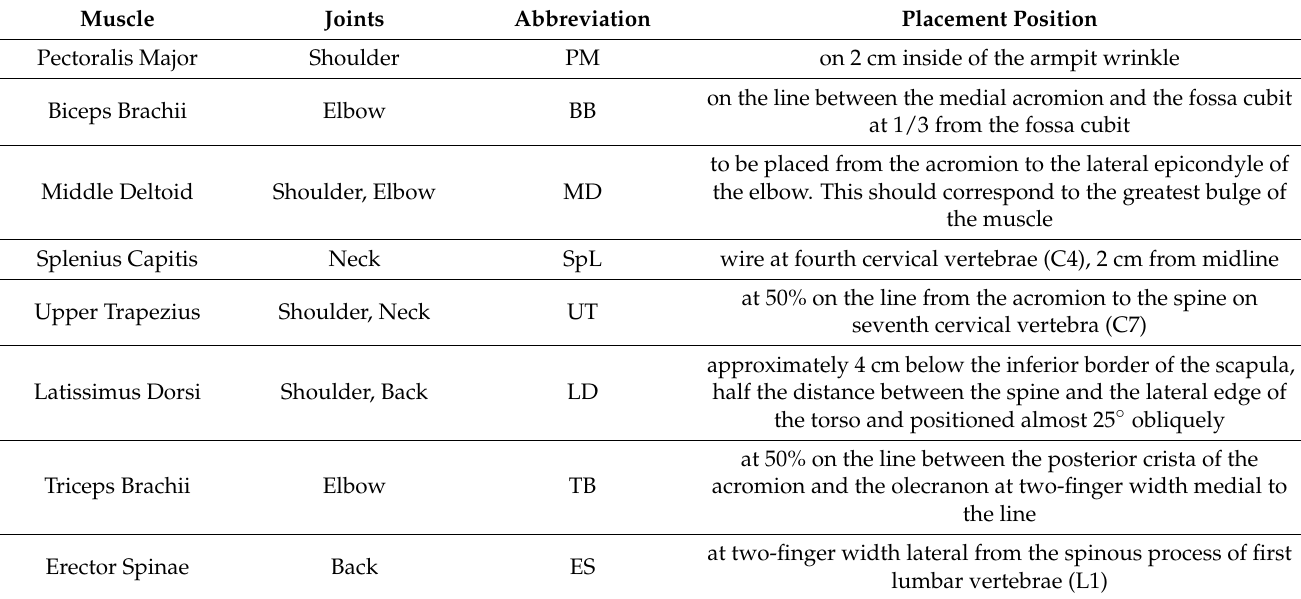
Table 6. Electrode placement position for eight